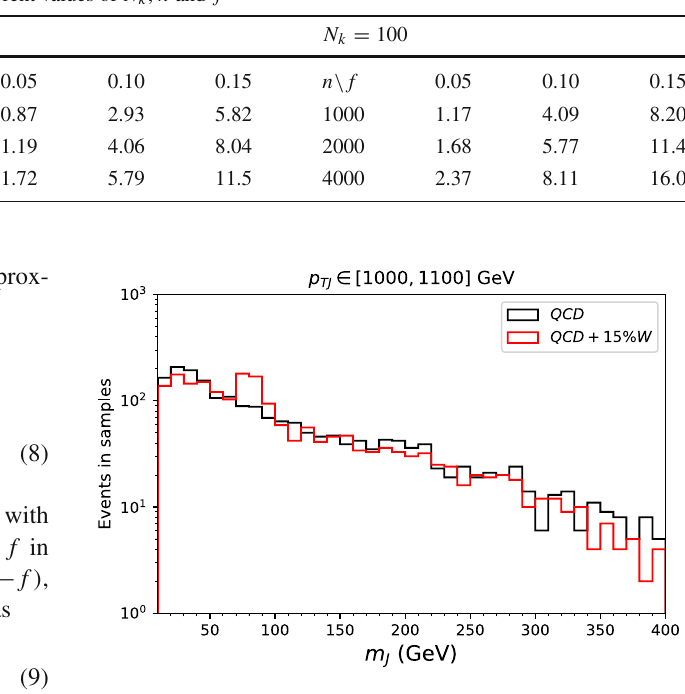
Fig. 4 Jet mass distributions for two pseudo-experiments with n = 2000. The first sample (black line) only contains QCD jets and the second sample (red line) contains a fraction f = 0 . 15 of W